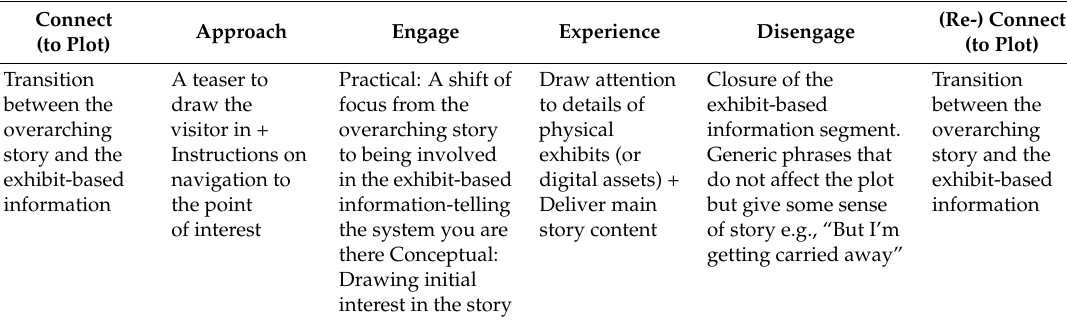
Table A1. 6-stage local trajectory for an Acropolis Museum experience.